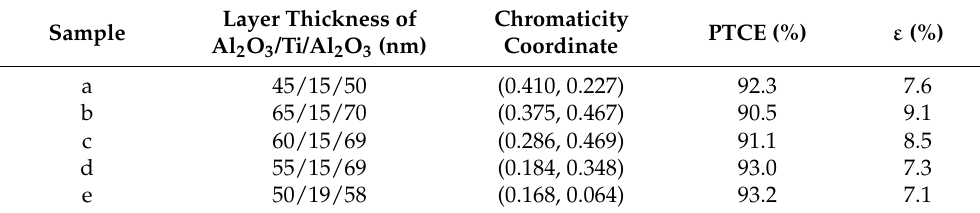
Figure 3. Optical reflectance spectra and color photos of the five fabricated samples ( a )–( e ) corre- sponding to the five points in Figure 2b. ( f ) Measured reflectance spectra for fabricated sample ( b ). Table 1. Layer thicknesses of Al 2 O 3 /Ti/Al 2 O 3 , chromaticity coordinates, PTCEs and ε s of fabricated samples (a)–(e) in Figure